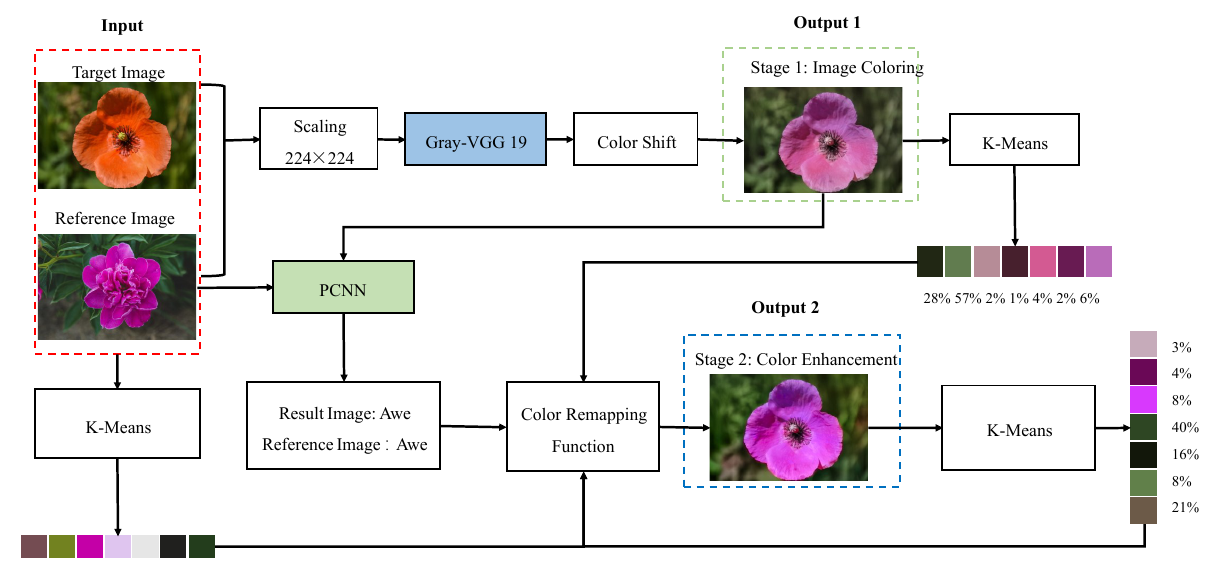
Figure 2. Block diagram of our